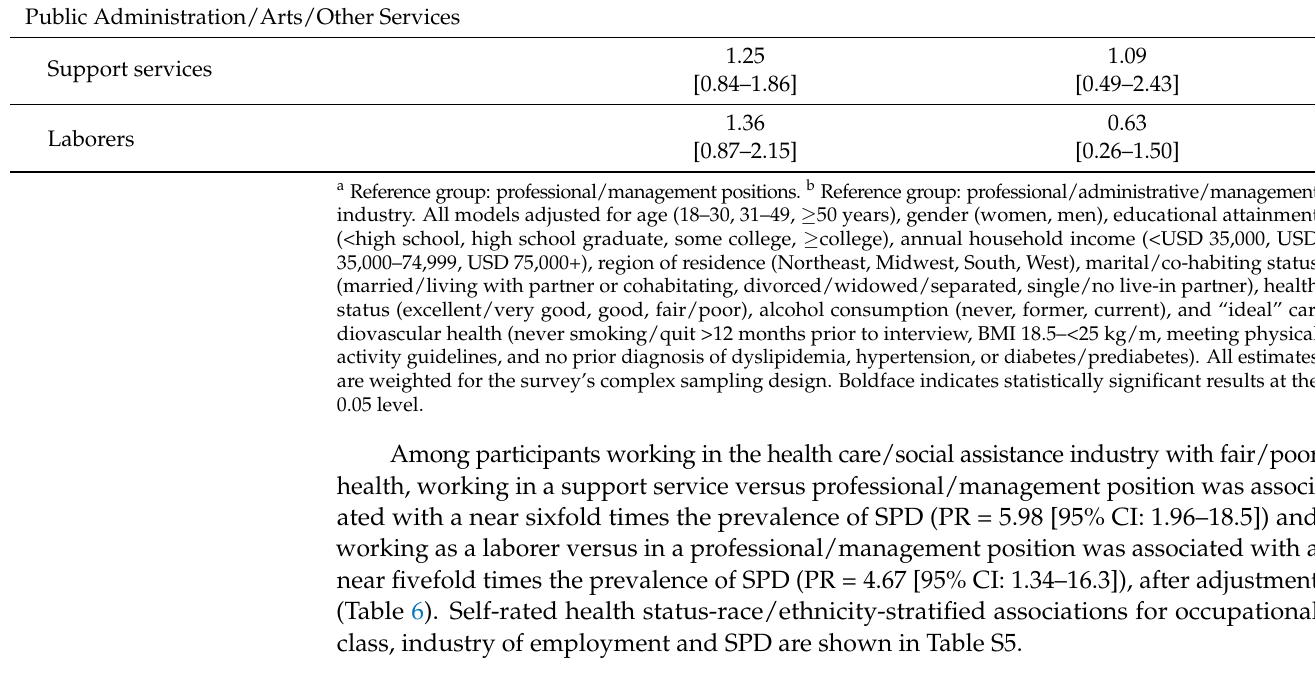
(Table 6). Self-rated health status-race/ethnicity-stratified associations for occupational class, industry of employment and SPD are shown in Table